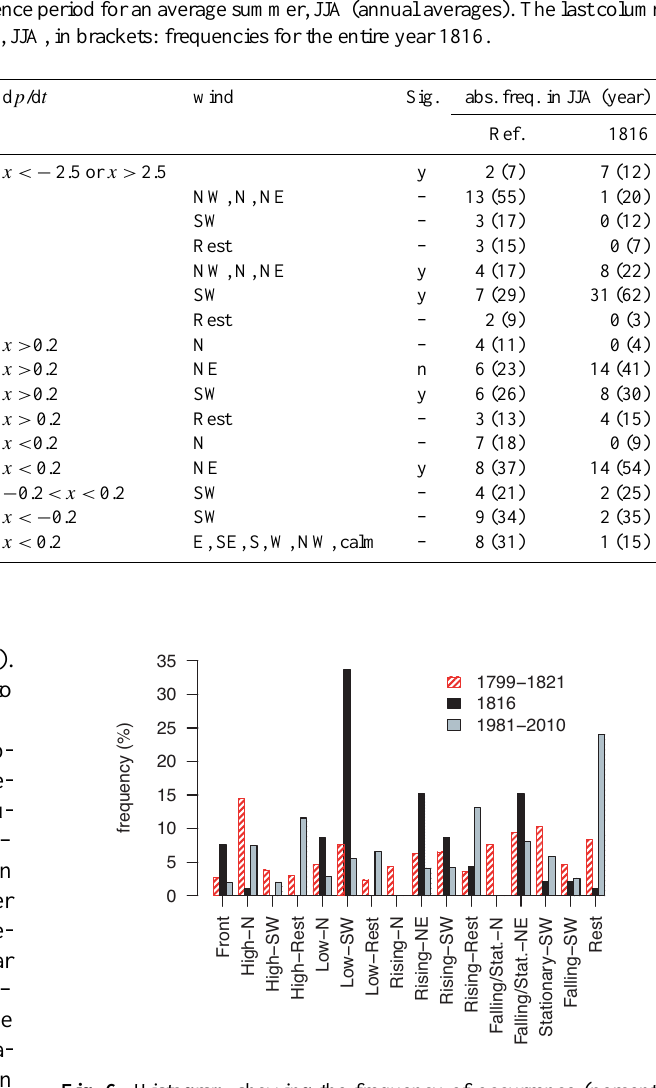
Fig. 6. Histogram showing the frequency of occurrence (percent) of weather types in the summer months (June to August) of 1816 (black), in the reference period (red patterned), and in the period 1981–2010 (light